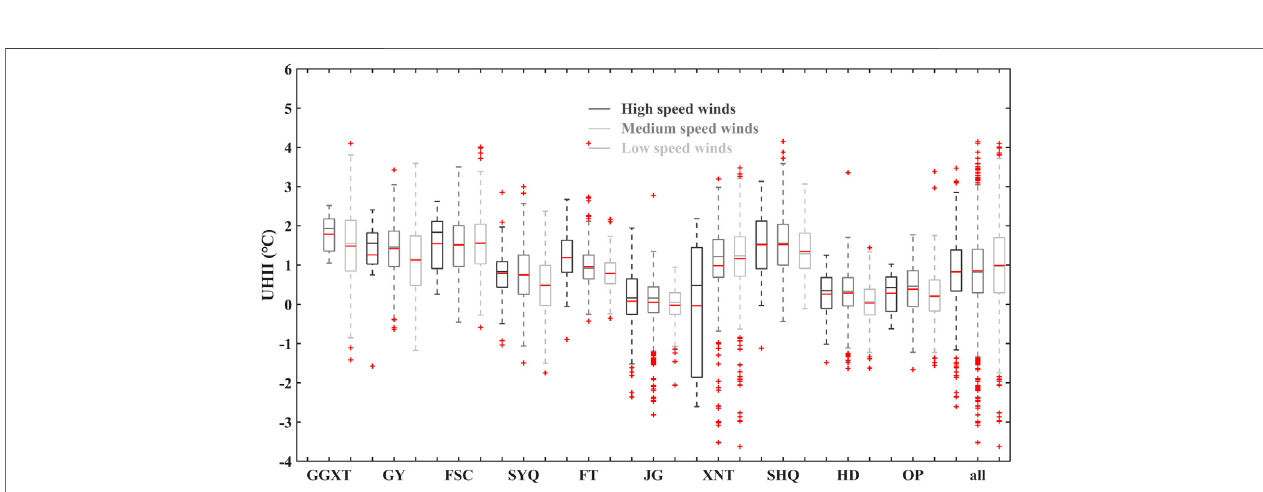
FIGURE 5 | Box-and-whisker plots of the UHII values under different wind speed conditions at each urban station during 2014 – 2020. In the plots, the central box representsthevaluesfrom thelowertoupper quartile (25th to75thpercentile).Thevertical lineextends from themaximum totheminimumvalue. Themiddle black solid line represents the median, the middle red solid line represents the average, and the red plus signs represent outliers.